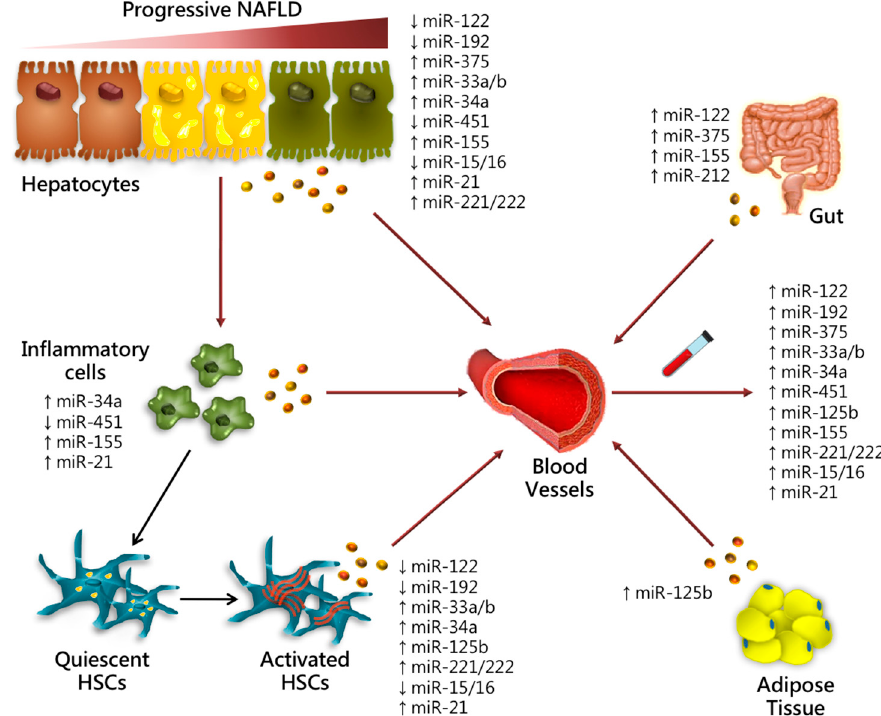
Figure 1. Role of miRNAs in progressive NAFLD. Schematic illustration of candidate miRNAs expression in different hepatic cell types (hepatocytes, inflammatory cells i.e., Kupffer cells, HSCs) and into the circulation triggering steatosis onset, inflammation and ECM deposition. Circulating